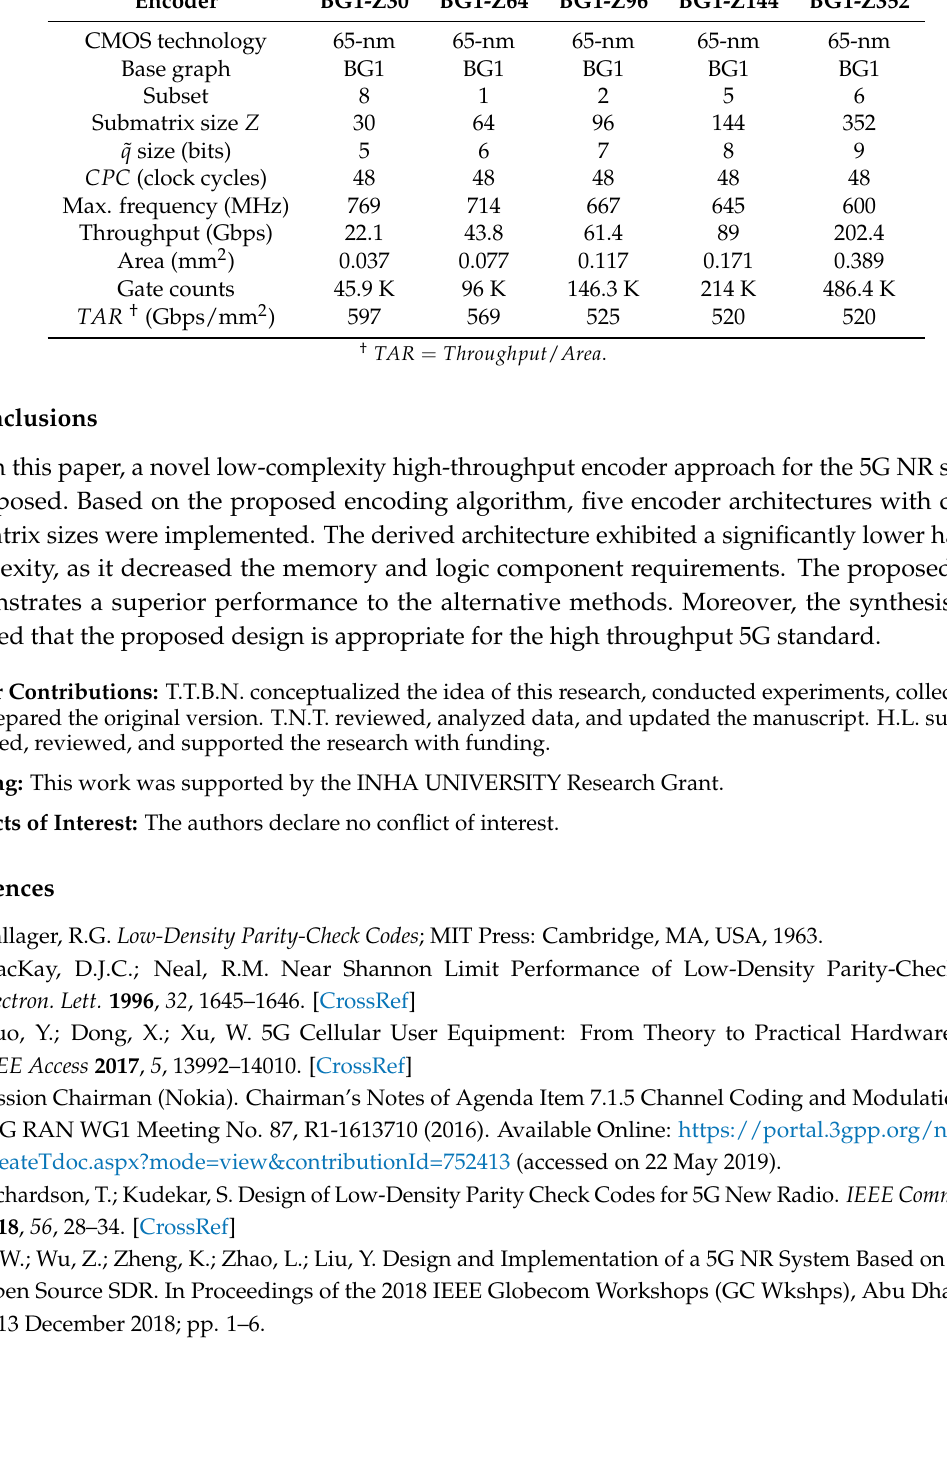
Table 7. ASIC implementation results of LDPC encoders for different lifting sizes Z = 30, 64, 96, 144, and 352. Encoder